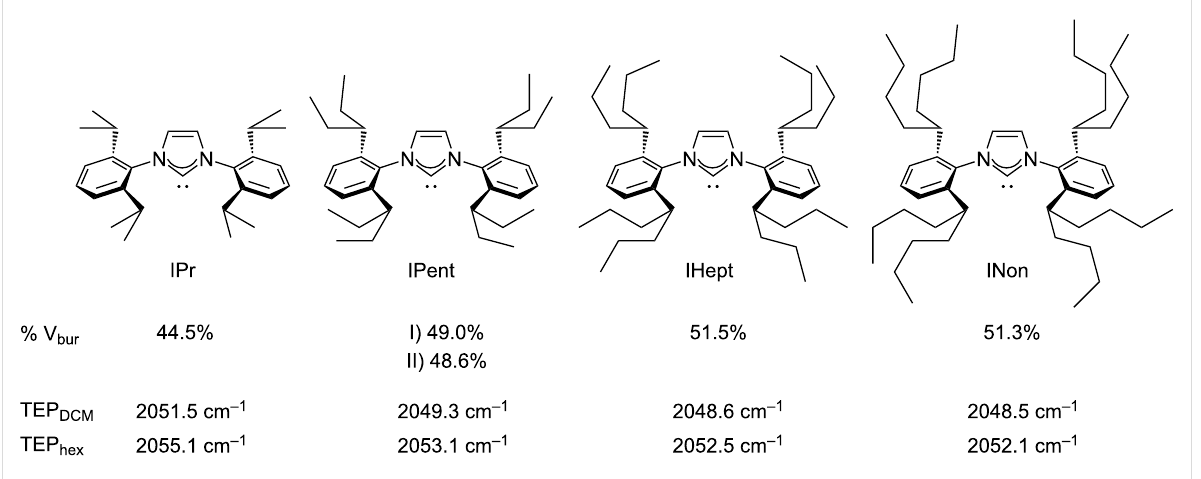
Figure 1: ‘ITent’ family of ligands, including IPr. First row: percentage buried volume (% V bur ) calculated in [Au(ITent)Cl] complexes using the Samb V ca software [42-45]. Second and third row: Tolman Electronic Parameter (TEP) calculated from IR measurements in solution of the [Ni(ITent)CO 3 ] complexes